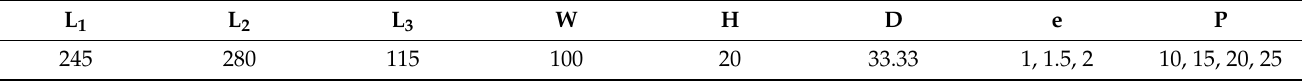
Table 1. Geometric parameters (all in mm) of ribbed SAH